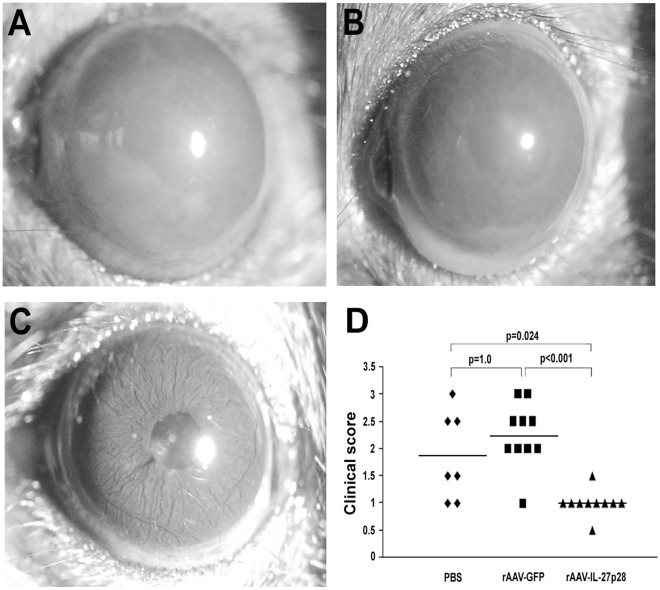
Clinical evaluation of EAU activity.rAAV2-CMV-mIL-27p28 was subretinally injected into the eye, PBS and rAAV2-CMV-GFP were used as controls. Three weeks after injection, mice were immunized to induce EAU with IRBP161–180 peptide and slit lamp microscopy was used to examine ocular inflammation. Images show significantly more severe inflammation in the PBS (A) and rAAV2-CMV-GFP injected eyes (B) as compared with the rAAV2-CMV-mIL-27p28 treated eye (C). Clinical scoring on day 12 after immunization (D) showed that the PBS injected eyes had a score of 1.86 (±0.8) and the rAAV2-CMV-GFP injected eyes reached a mean clinical score of 2.25 (±0.59), whereas the score of rAAV2-CMV-mIL-27p28 treated eyes was 1 (±0.24, p = 0.024, p<0.001, respectively). The scores of three chosen eye pictures are 3, 3 and 0.5, respectively. Each point represents an individual eye, the average scores of each group are denoted by the horizontal lines.